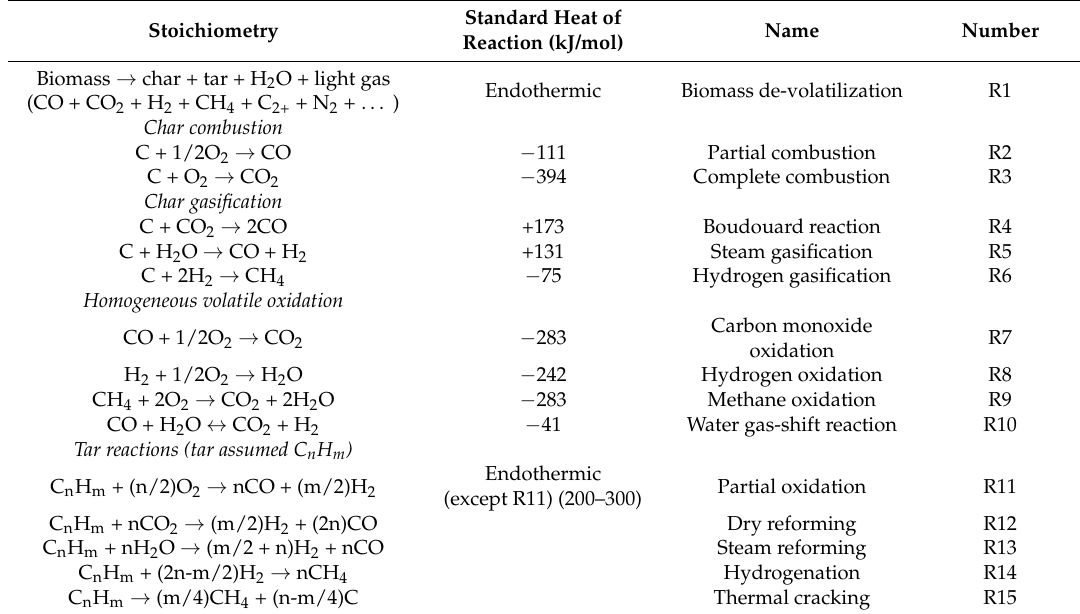
Table 1. Chemical reactions resulting from gasification